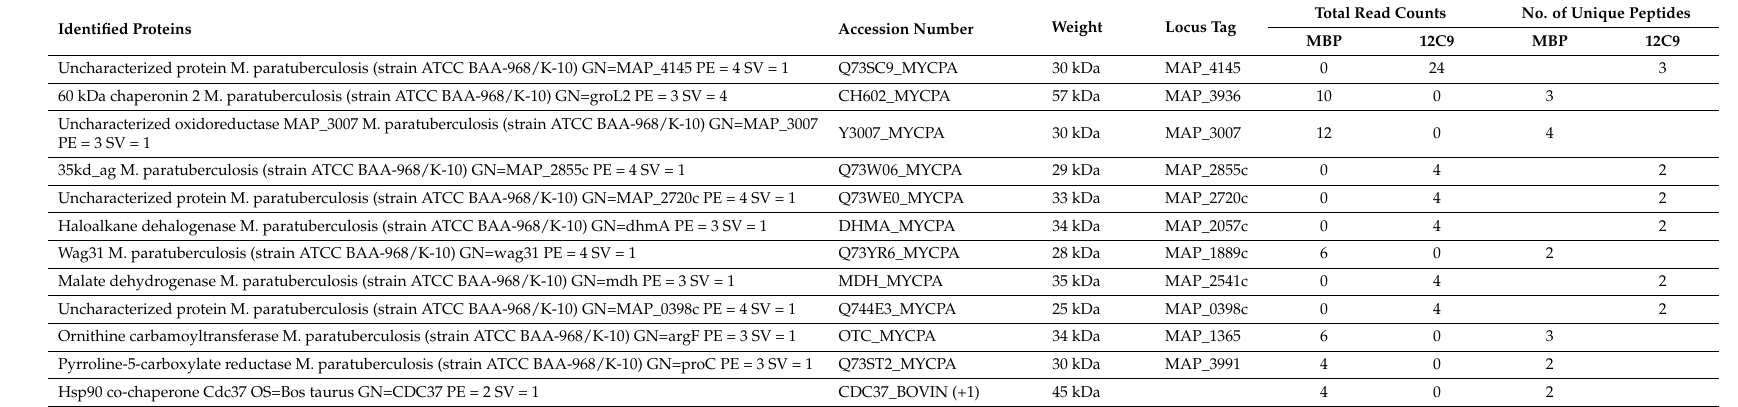
Table 1. Mass spectrometry